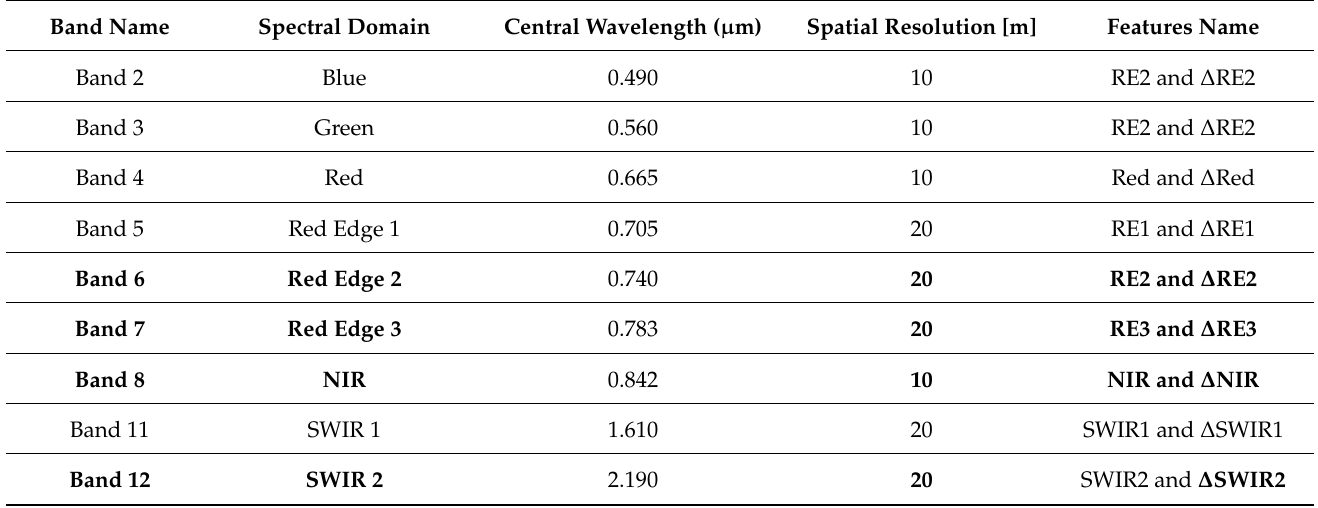
Table 1. MSI S2 spectral bands, spectral domain, central wavelength, spatial resolution and name used in this paper. Temporal difference ( ∆ ) is the reflectance difference between post-fire and pre-fire S2 images. In bold are the spectral bands and difference used as input features for the BA mapping algorithm in this study.